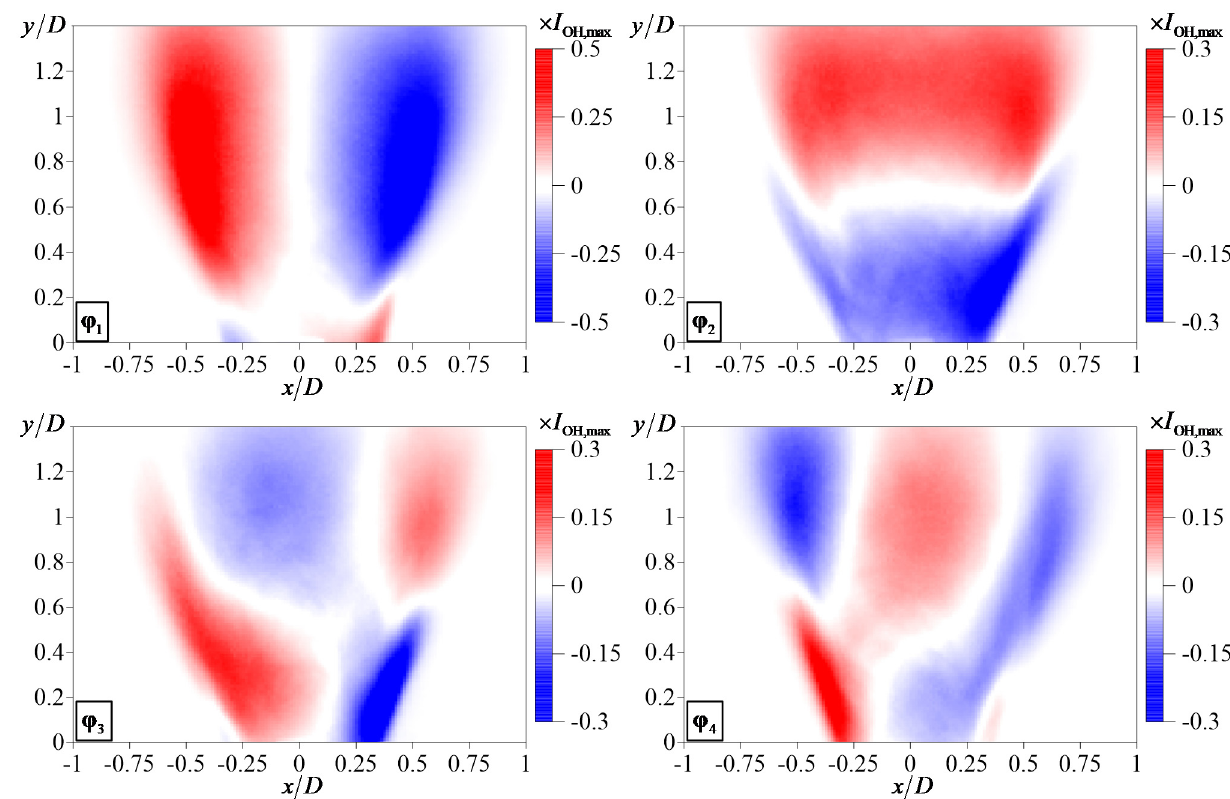
Figure 15. Four first PCA modes of OH* chemiluminescence images for methane flame at normal conditions.